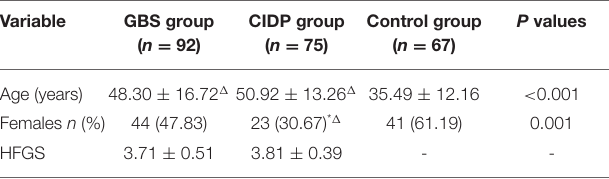
TABLE 1 | Comparison of the clinical data in the GBS, CIDP and control groups x ± s.